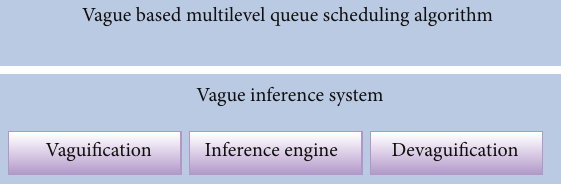
Figure 2: 2-layered architecture of VMLQ scheduler.